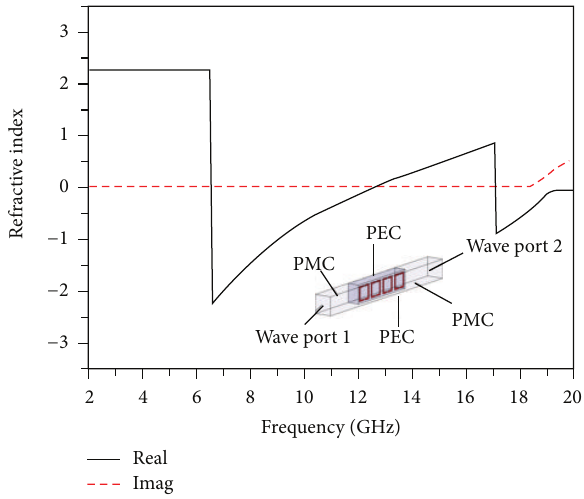
Figure 10: Effective refractive index of the LHM structure.